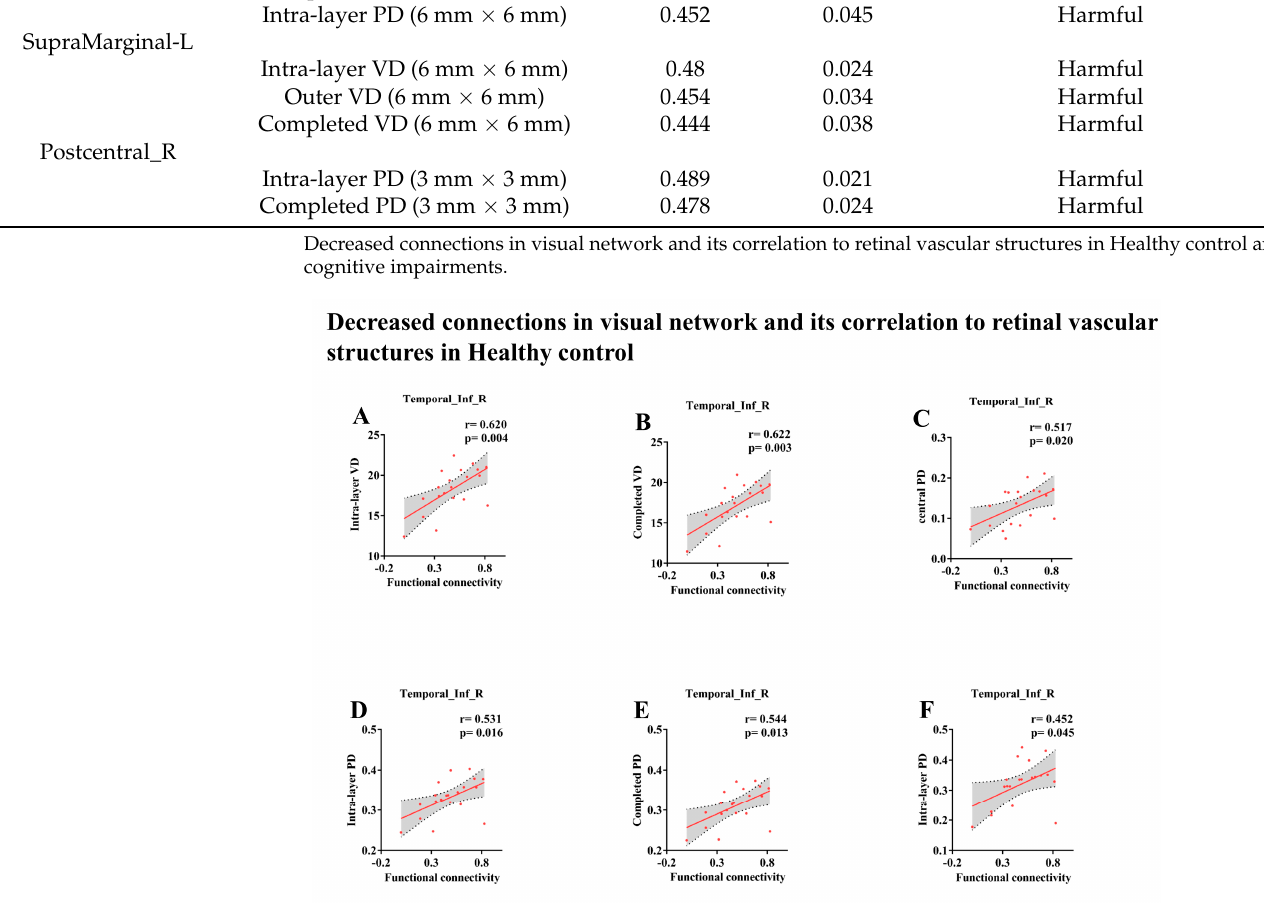
Figure 3. Decreased connections in visual network and its correlation to retinal vascular structures in Healthy control.The functional connectivity strength in right inferior temporal gyrus was associated with Intra-layer VD (3 × 3 mm, ( A )), Completed VD (3 × 3 mm, ( B )) and Central PD (3 × 3 mm, ( C )) Completed PD (6 × 6 mm, ( D )), Intra-layer PD (3 × 3 mm, ( E )) and Intra-layer PD (3 × 3 mm, ( F )) in HC group.